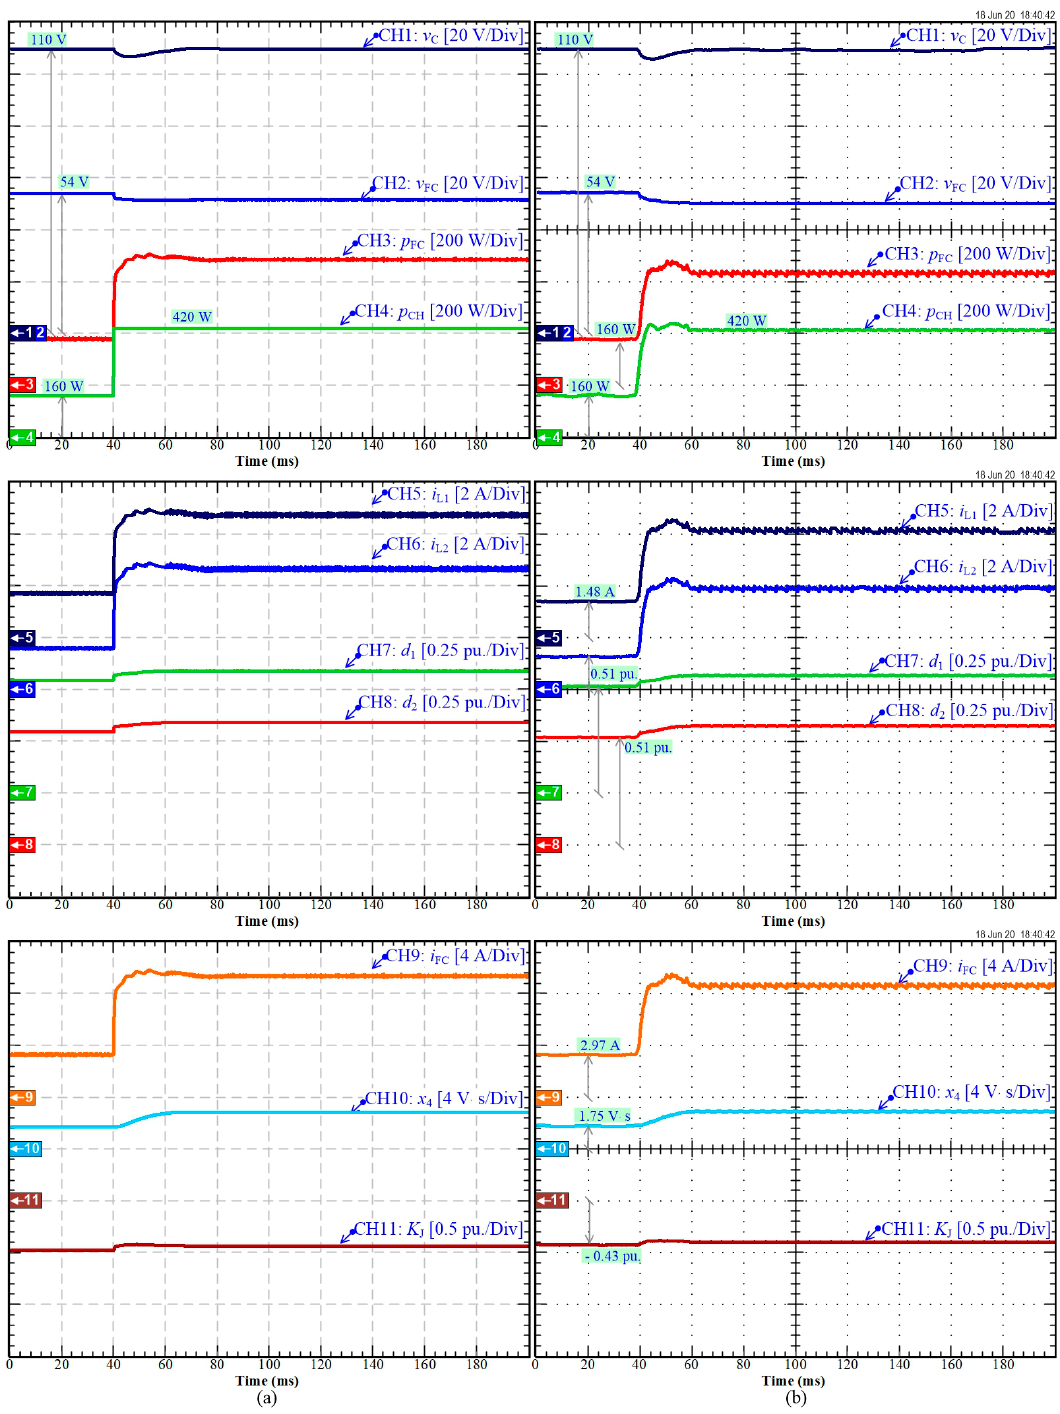
Figure 10. Dynamic characteristics of the FC converter in a CPL step from 160 to 420 W: ( a ) Simulation results; ( b ) Experimental results.